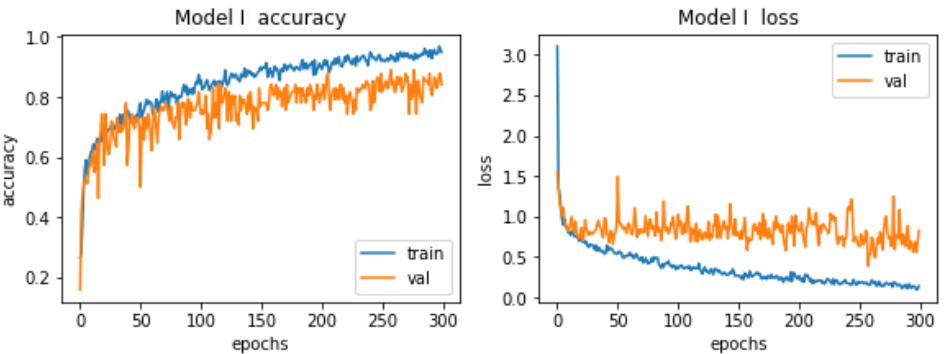
Figure 11. Accuracy and losses when teaching the first